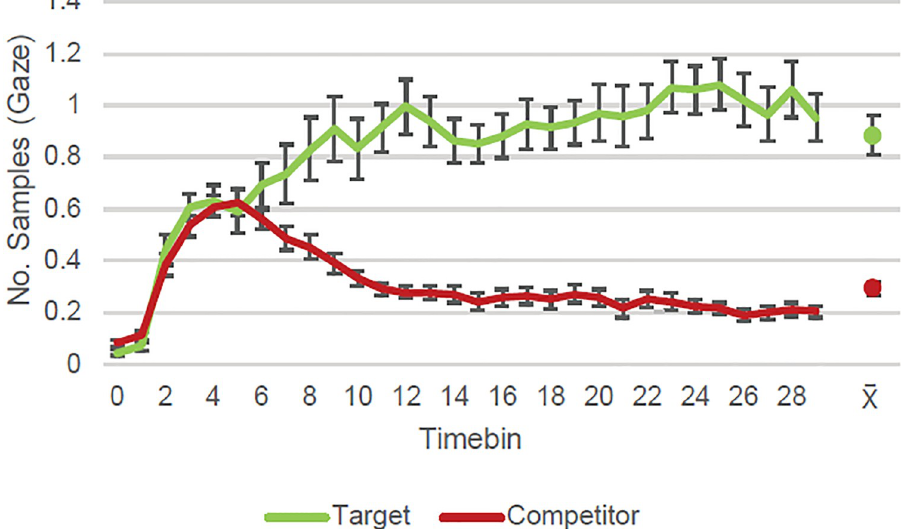
Fig 3. Correct recognition and source responses. In the time window of interest (starting at timebin 5; 500 ms after stimulus onset), participants looked more to the correct target quadrant than to the competitors when they recognized the cue and correctly identified its source location. The graph shows eye-tracking samples (per trial/per subject) with gaze detected (and S . E . of the mean) during retrieval according to quadrant content for trials with correct source memory. Data aggregated on 100 ms time bins. The dots represent each line’s average (and S . E .) across the time window of interest (timebins 5–29).